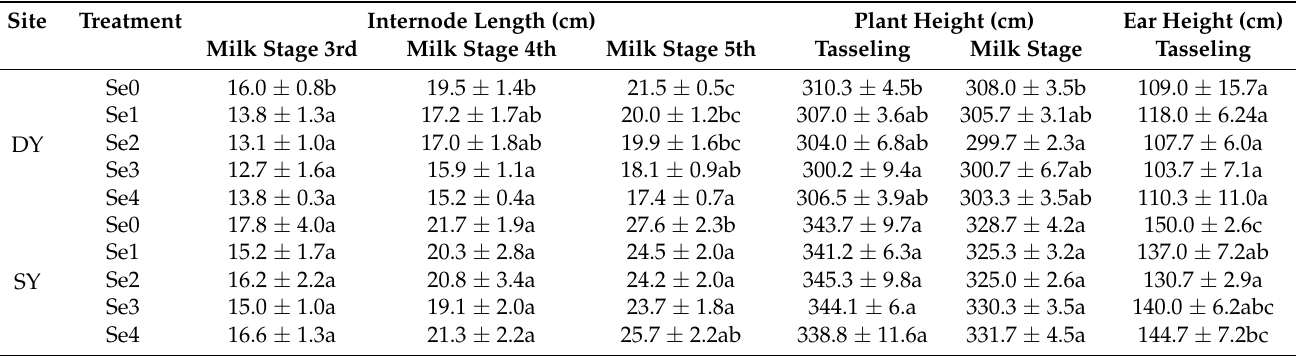
Table 6. Effects of Se fertilizer application on plant height and ear height of maize at locations DY and